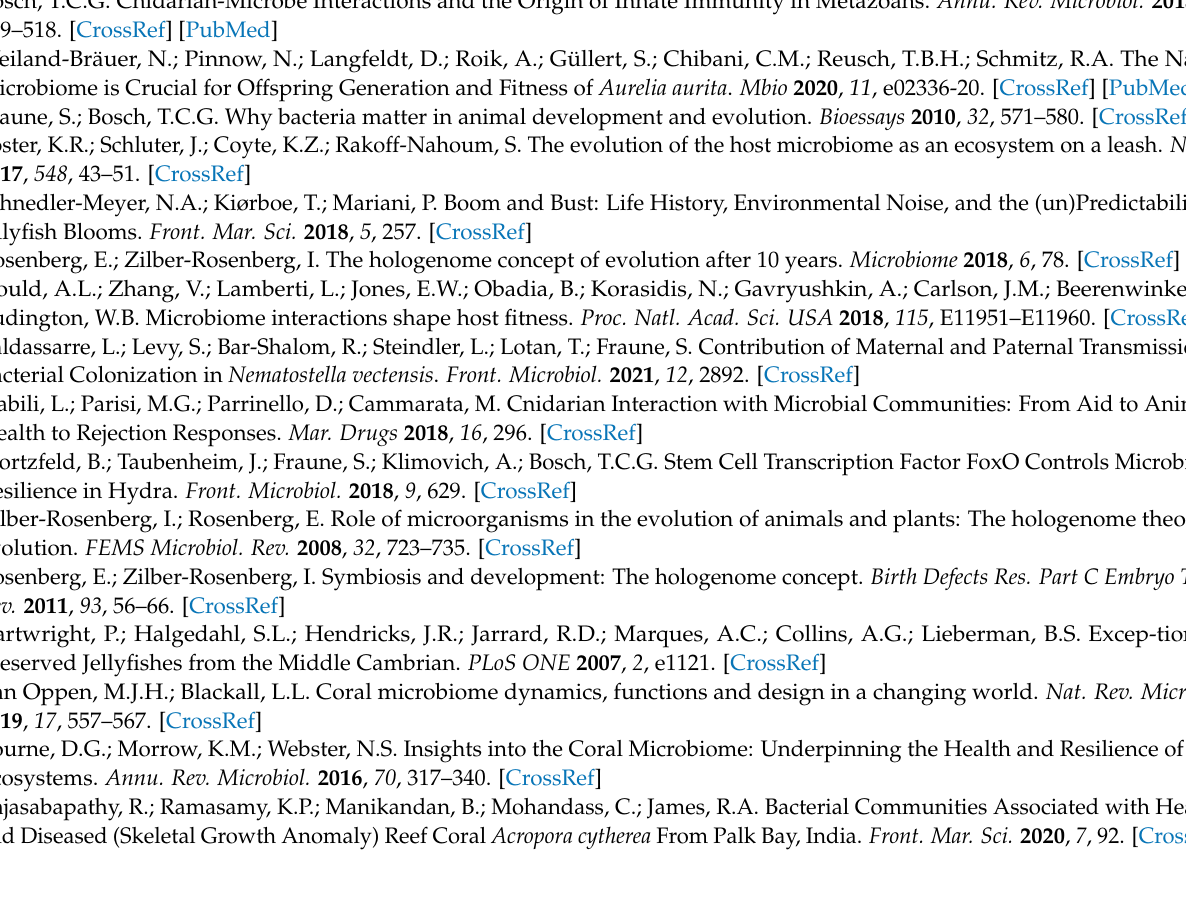
studies in cnidaria; Table S3: ASVs used for BLAST analysis; Table S4: Mock community ASVs table. Table S5: PERMANOVA test for separate and merged data sets; Table S6: SIMPER test for different primers and tissue types; Table S7: Manual BLAST